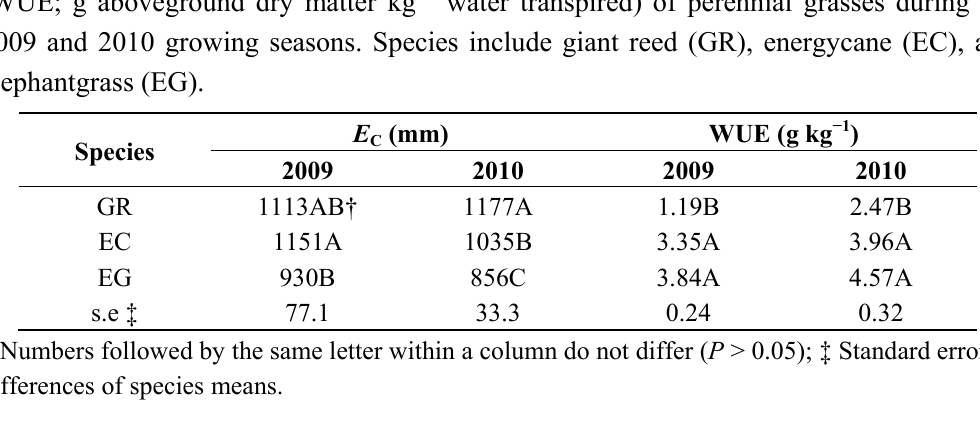
Figure 1. Daily crop transpiration ( E ) during the 2009 (A) and 2010 (B) growing seasons. C Species include giant reed (GR), energycane (EC), and elephantgrass